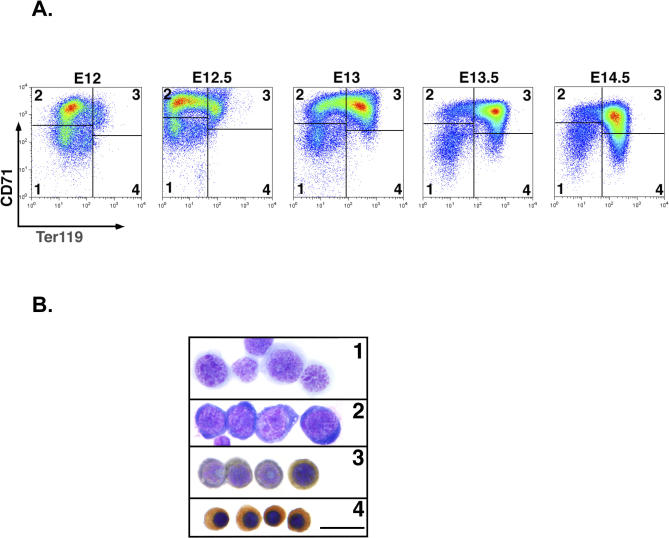
Erythropoietic Developmental Wave in Fetal Liver(A) CD71/Ter119 flow-cytometric histograms of fetal liver cells derived from embryos between E12 and E14.5. Developmental states 1 to 4 are noted.(B) Cytospin preparations of E14.5 fetal liver cells sorted from each of states 1 to 4 show increasingly differentiated erythroid progenitors. Cells were stained for hemoglobin expression (brown) with diaminobenzidine and counterstained with Giemsa. Scale bar = 20 μm.Developmental states 1 to 4 are defined as described in the text and in Protocol S1, section 1.1.